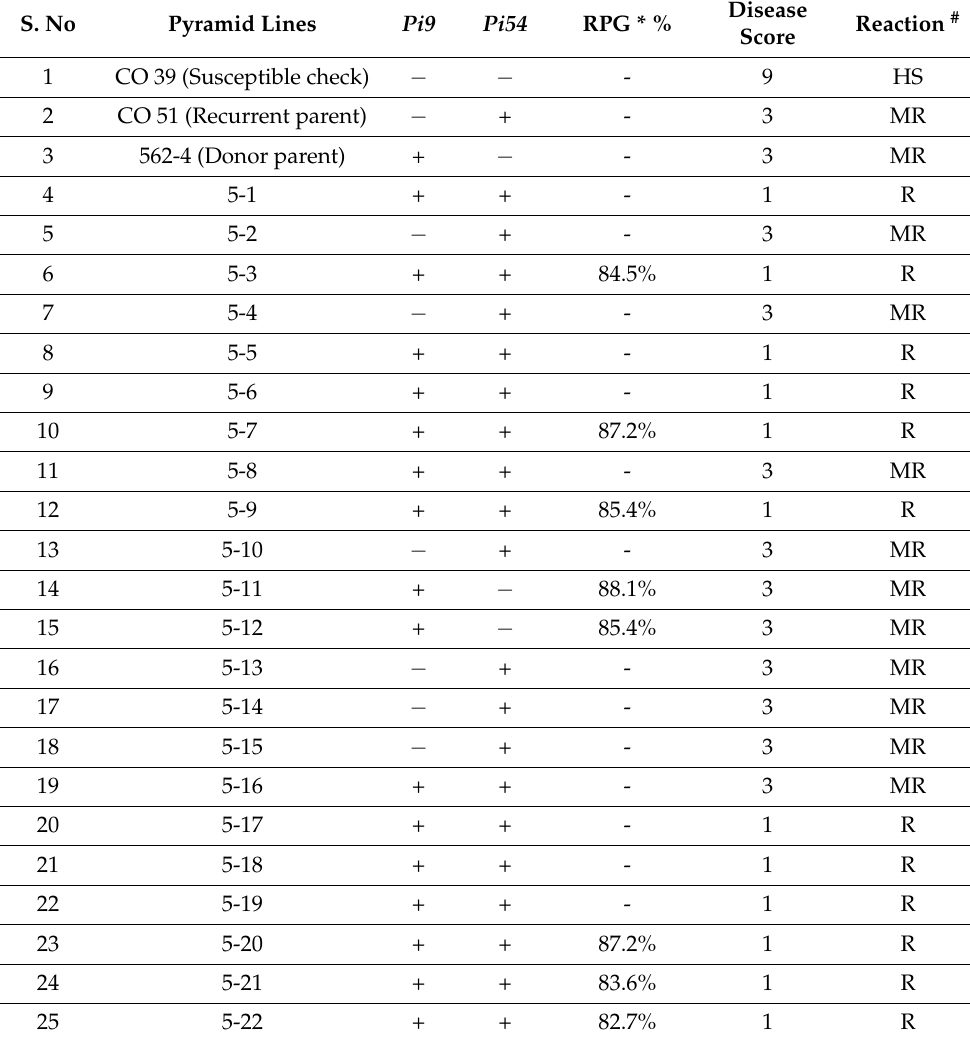
Table 1. Details of the BC 2 F 2 lines that harbor the blast resistance genes, Pi9 and Pi54 . S. No Pyramid